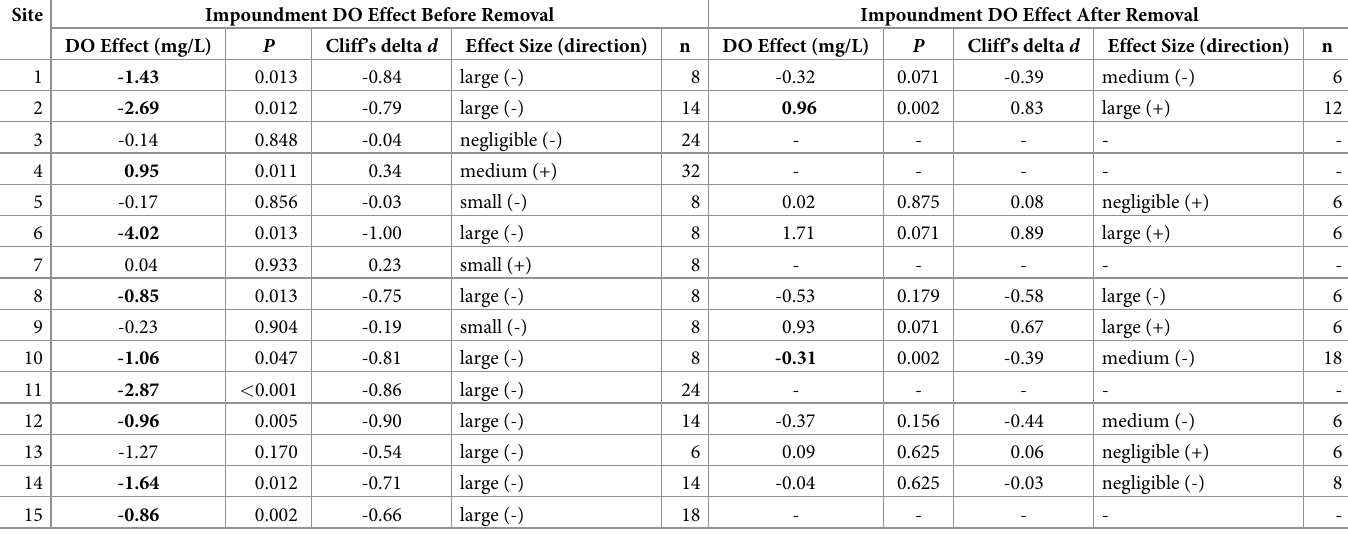
Table 3. Differences in mean daily dissolved oxygen between impoundment and upstream references before and after dam removal, also termed the impoundment DO effect. Site